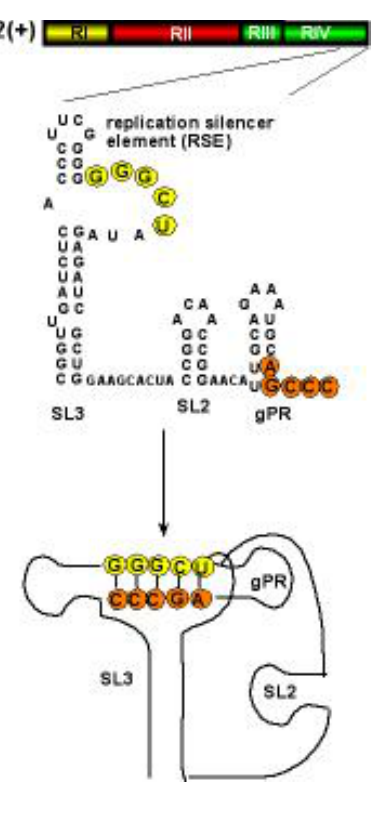
Figure 3. The predicted secondary and tertiary structure of the 3' UTR in DI-72(+) RNA. A 5 nt base-pairing between RSE in the internal loop sequence of SL3 and gPR stabilizes the tertiary structure. This interaction is critical for the assembly of the functional TBSV replicase